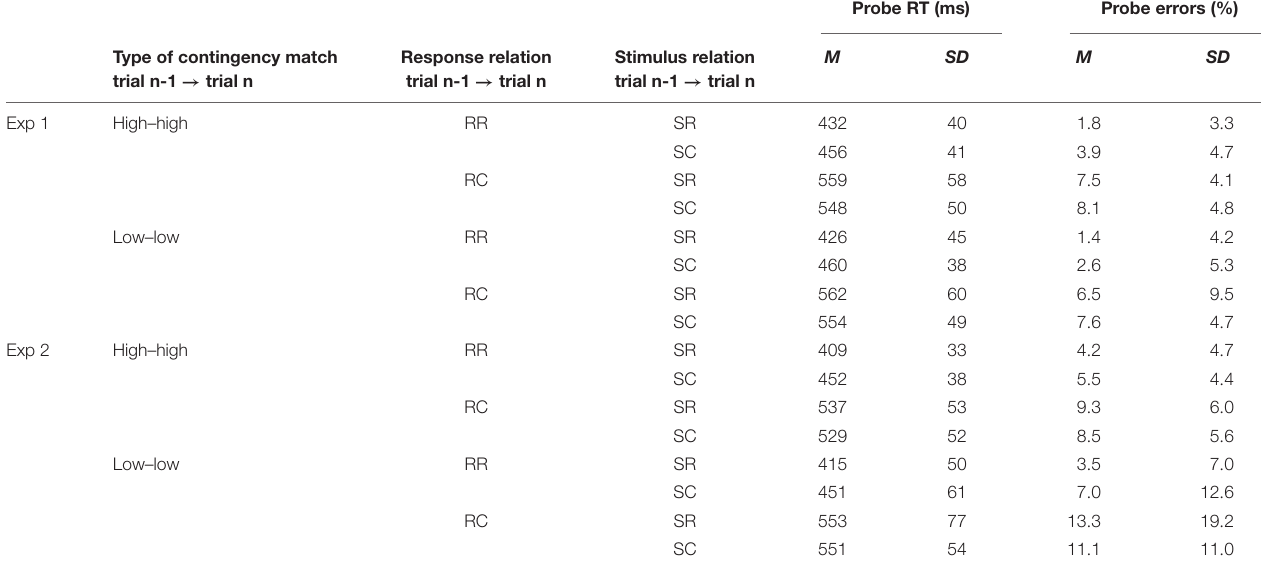
TABLE 2 | Results for SRBR effects (probe RT and error rates) in Experiments 1 and